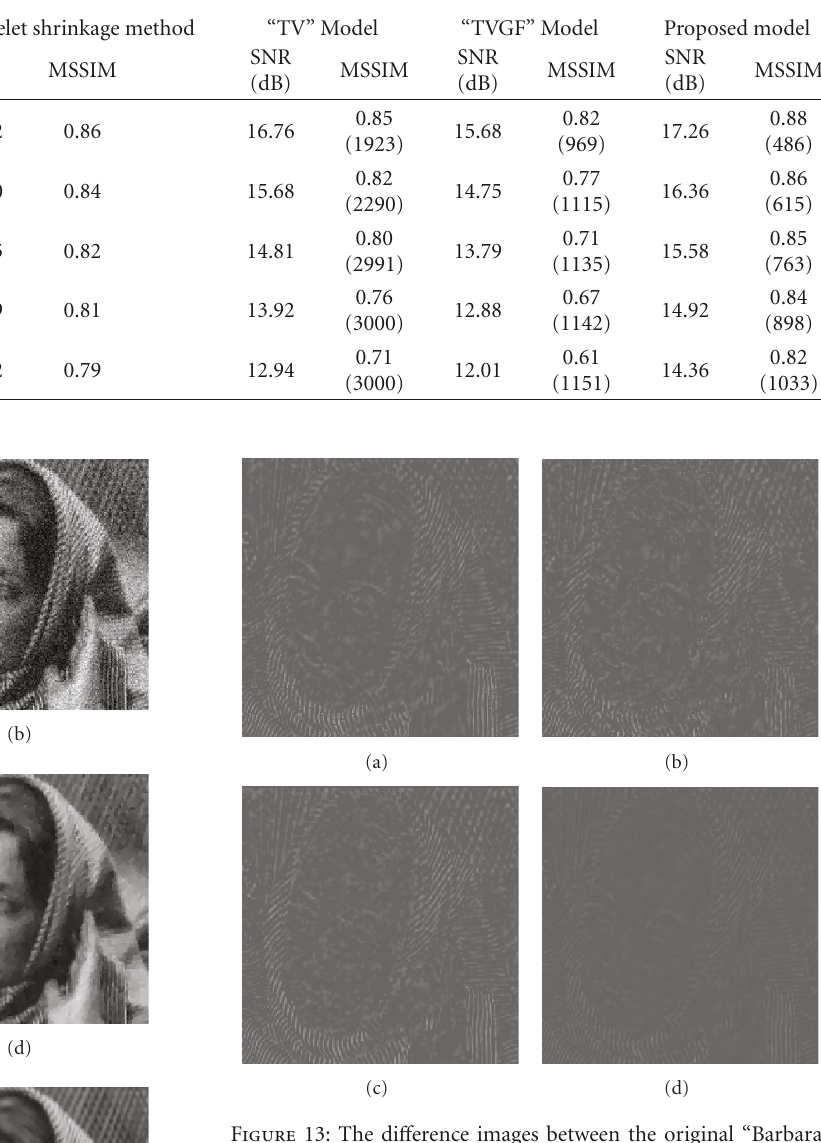
Figure 13: The di ff erence images between the original “Barbara” and restored “Barbara” images in Figure 12: (a) by the curvelet Shrinkage method; (b) by using the “TV” model; (c) by using the “TVGF” model; (d) by using our proposed